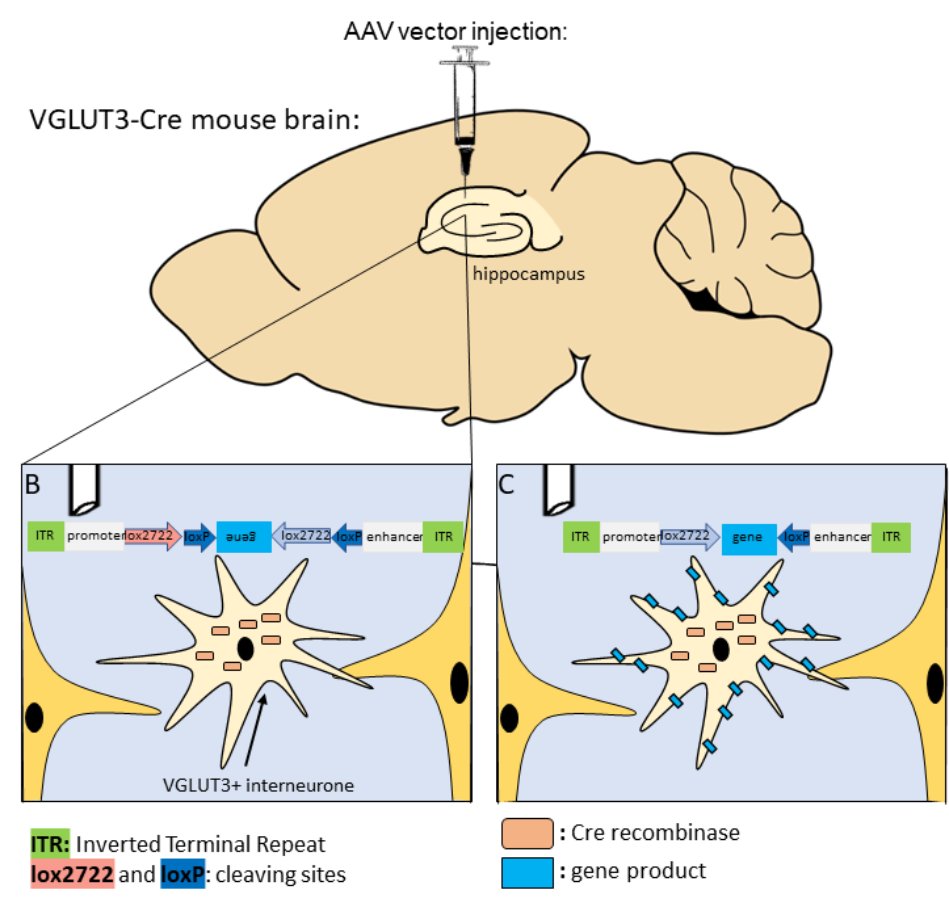
Figure 2. Schematic representation of how VGLUT3 ‐ Cre mice work with AAVs. The VGLUT3 ‐ Cre mouse strain expresses Cre recombinase enzyme under the promoter of VGLUT3. ( A ) Local microinjection of AAVs—for example, to the hippocampus—can be done via stereotaxical surgery. ( B ) The injected AAVs contain double ‐ floxed inverted open reading frame (DIO) construction. The promoter and enhancer regions enable stable and neuron ‐ specific gene expression. The specific lox ‐ P sites enclose the target gene, which is in the opposite reading order. Thus, non ‐ Cre expressing cells translating these sequences end up with non ‐ functional proteins. ( C ) Cre enzymes in the VGLUT3+ neurons are able to inverse the target gene and translate it into functional proteins. AAVs: adeno ‐ associated viral vectors; VGLUT3: vesicular glutamate transporter type 3.